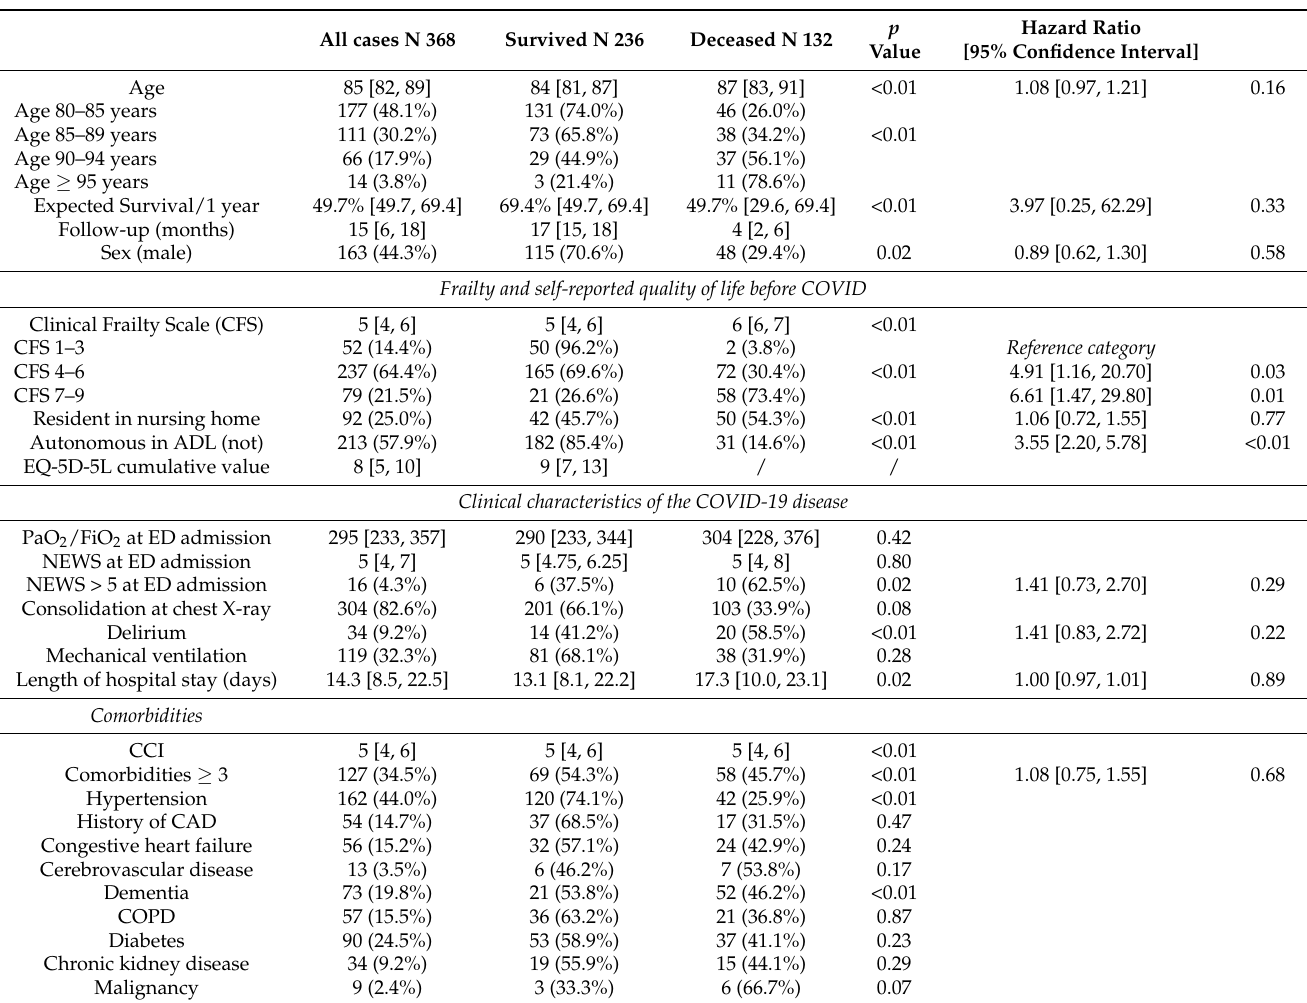
Table 1. Clinical characteristics of enrolled patients according to death at post-discharge follow-up. Adjusted hazard ratios were calculated by a multivariate Cox regression model (model chi-square = 119.586, p < 0.001; log-likelihood = 1394.384). Expected survival at 1 year was assessed based on data from the Italian Population registry in 2019. Proportions in the survived/deceased columns are reported as row